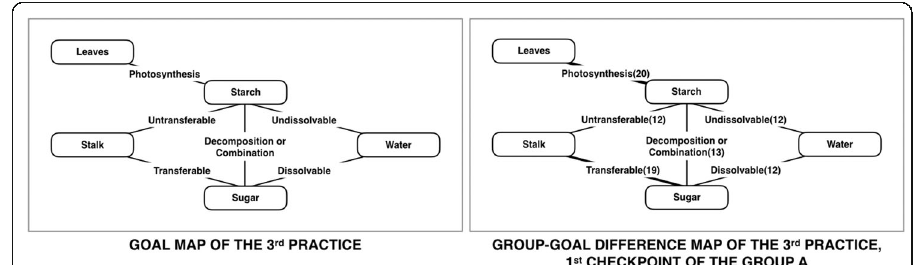
Fig. 11 The goal map and the group-goal difference map of the third